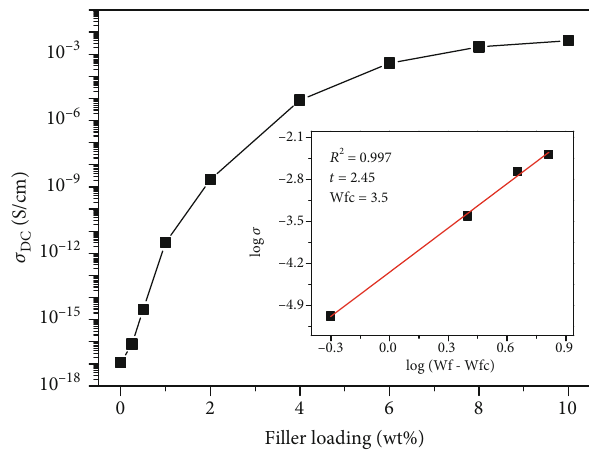
Figure 4: Electrical conductivity of the neat polymer and its recycled composites (inset shows a plot based on classical power law